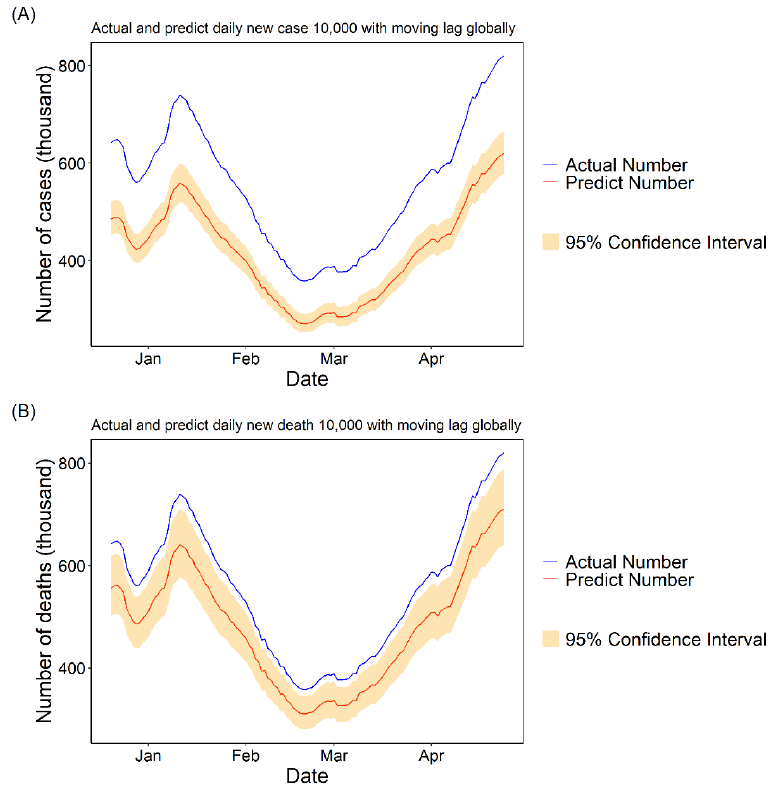
Figure 3. The actual and predicted daily cases and deaths numbers with a moving lag globally. The predicted number was calculated by multiplying the actual number of daily cases by the PC value of the best lag. ( A ) The PC value and related 95% CI are − 24.43 [ − 29.59, − 18.89] with the best moving lag of 30. ( B ) The PC value and related 95% CI are − 13.32 [ − 21.89, − 3.81] with the best moving lag of 30.